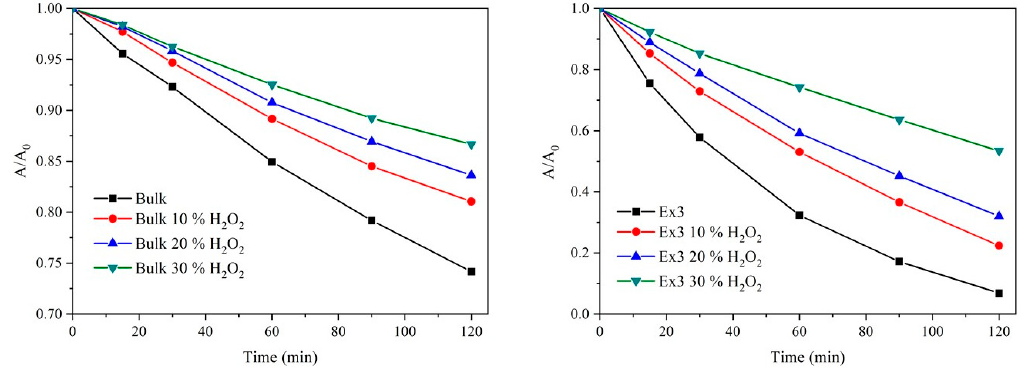
Figure 12. Photocatalytic degradation of AO7 in suspensions of bulk ( left ) and selected exfoliated GCN nanomaterials ( right ).